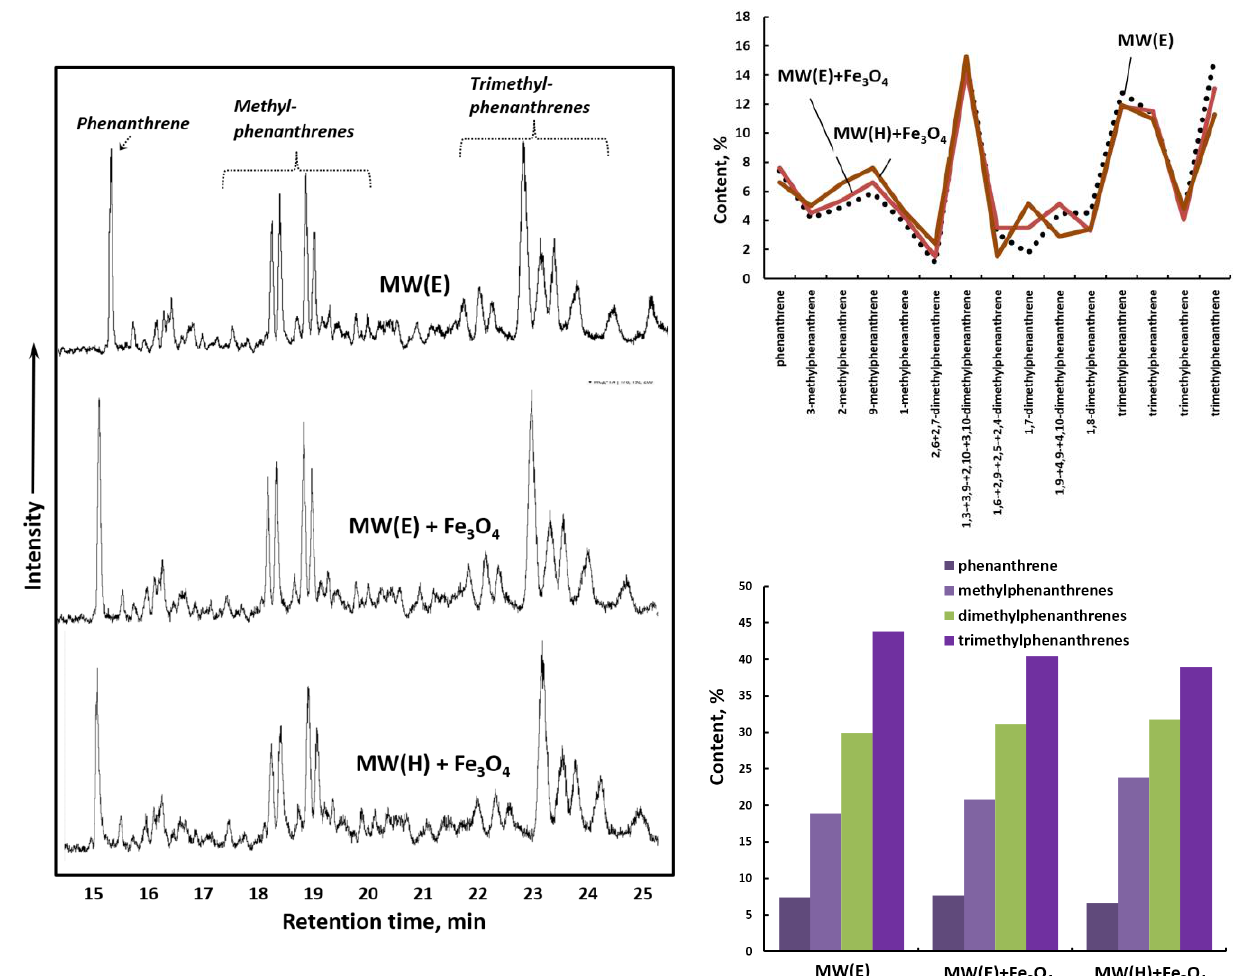
Figure 7. Chromatograms and relative contents of phenanthrene and its homologues in the aromatic fraction of the studied oil samples after exposure to microwave exposure. In the lower-right corner— changes in the content of phenanthrene and its homologues.